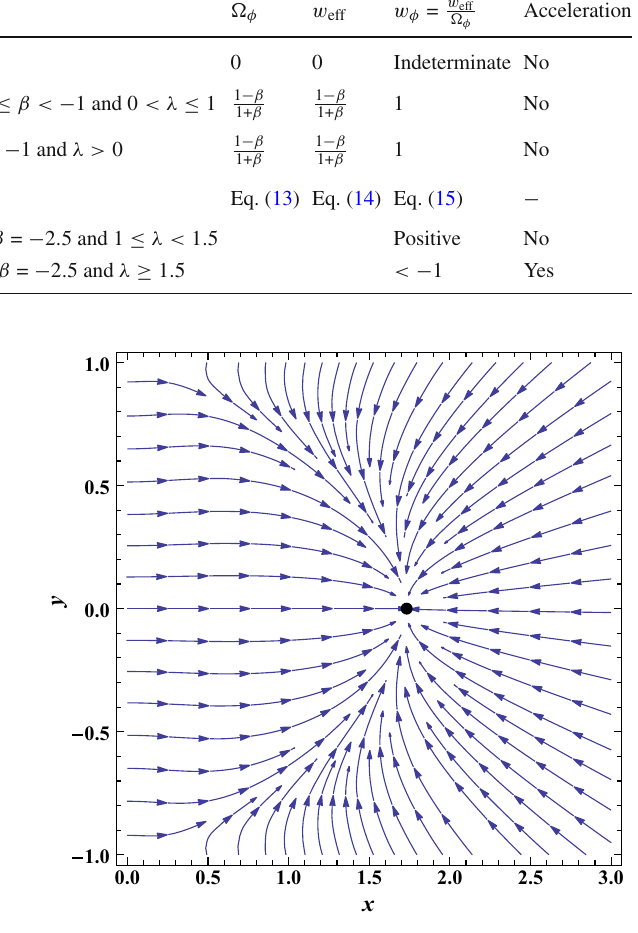
Fig. 5 The figure represents the evolution of the phase space trajecto- ries of Case (3) for Q = σ ( ˙ ρ m + ˙ ρ φ ), and it is plotted for σ = 2 and λ = 1. The stable point acts as an attractive node, and the black dot designates a stable attractor point